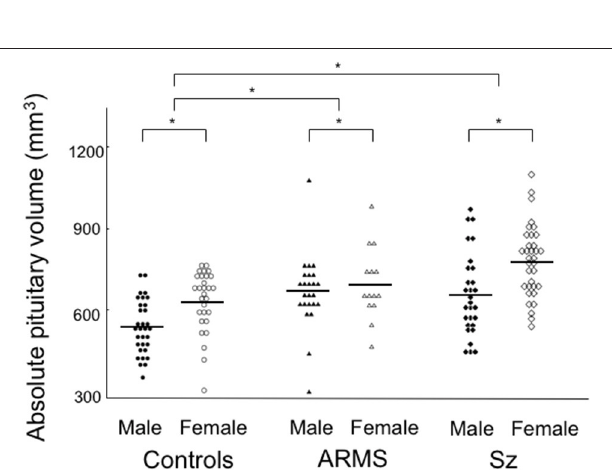
FIGURE 1 | Sagittal (left) and coronal (right) views of the pituitary gland manually traced in this study. The pituitary stalk was excluded from the tracings, but we included a posterior bright spot, corresponding to the posterior pituitary (the intensity of which is thought to reflect vasopressin concentrations).